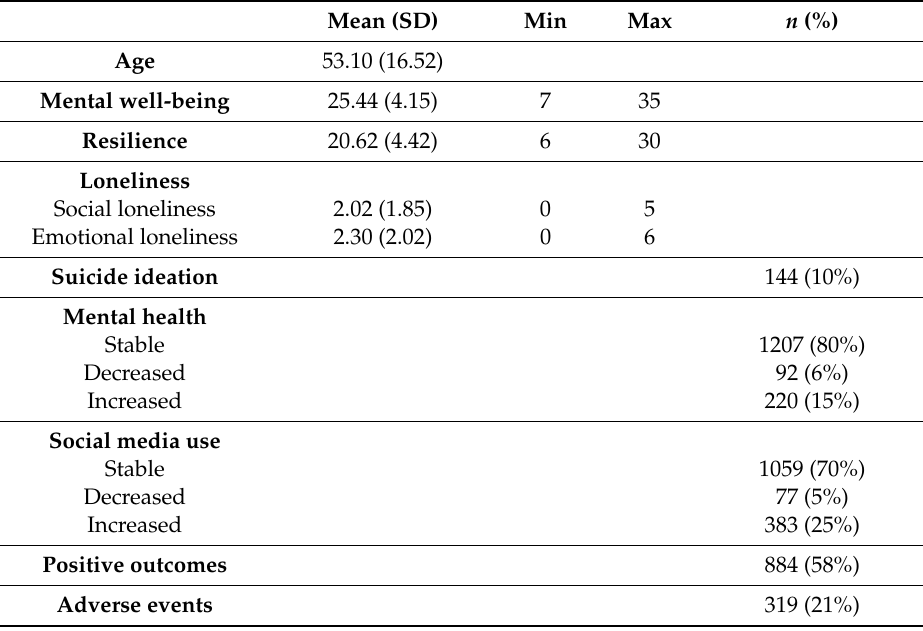
Table 1. Demographic data and mean value total scores for mental health and e ff ects of